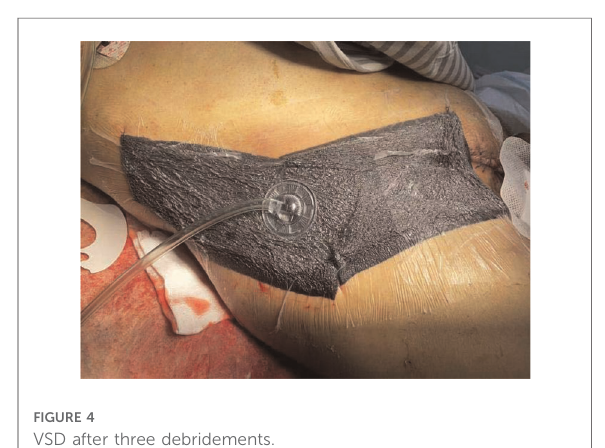
FIGURE 4 VSD after three